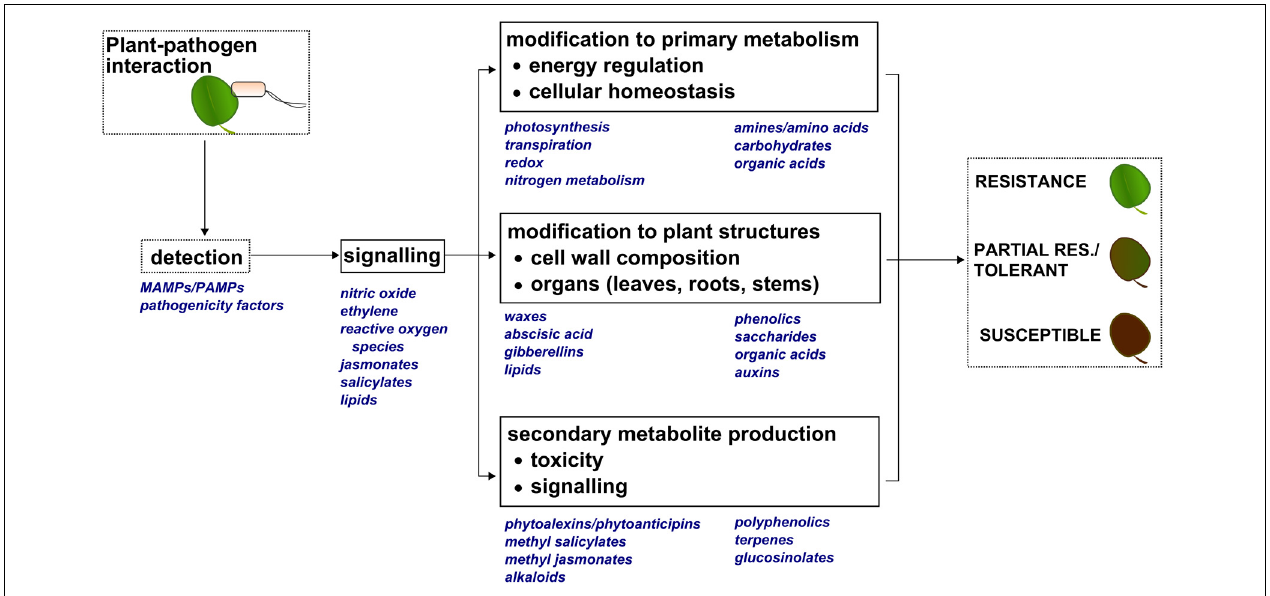
FIGURE 1 | Molecular and physiological modifications that can occur during a plant-pathogen interaction. Upon detecting Pathogen- or Microbe-Associated Molecular Patterns (PAMPs, MAMPs), small molecules are produced that act as molecular signals to